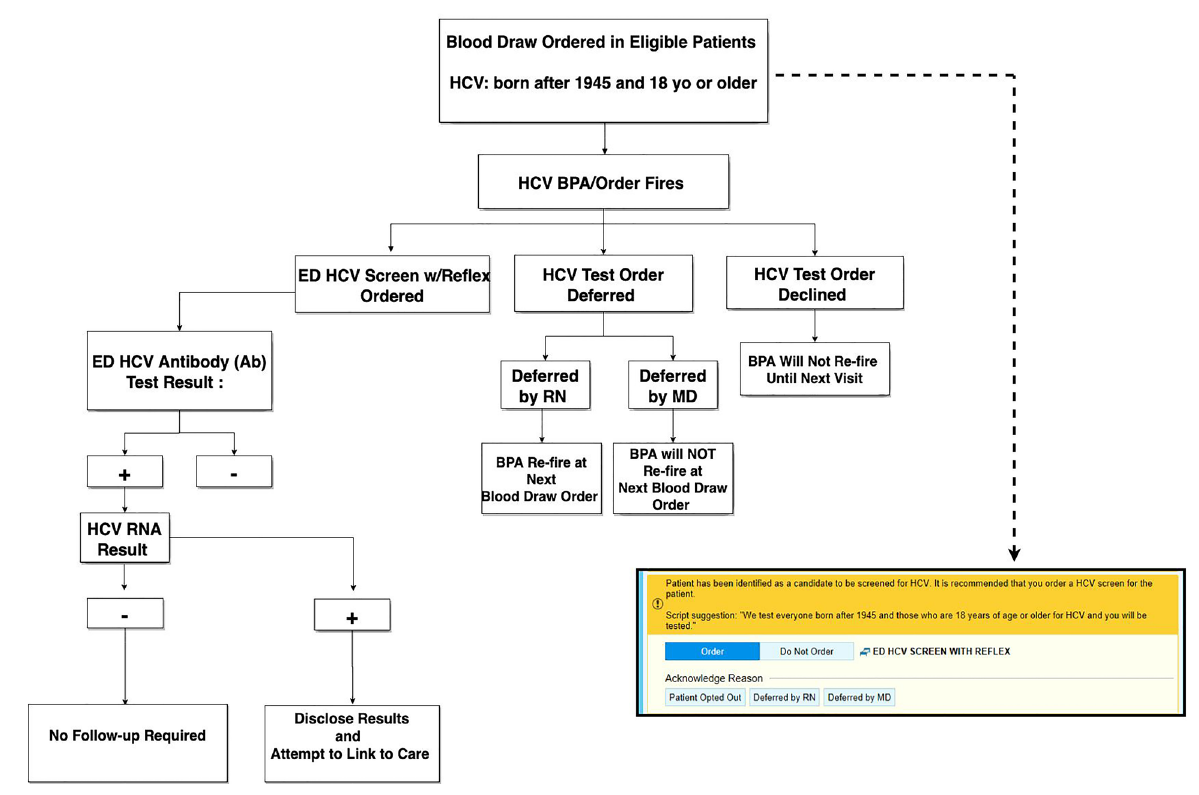
Figure 1. Operational model of the hepatitis C screening program in the emergency department. HCV , hepatitis C; HIV, human immunodeficiency virus; Ab , antibody; BPA , best practice